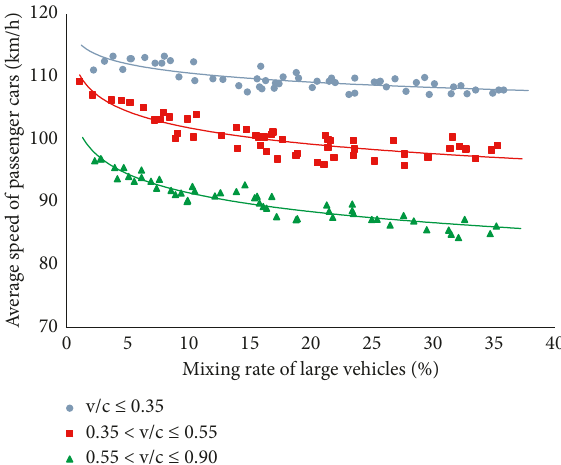
Figure 5: Relationship between the mixing rate of large vehicles and average speed of passenger